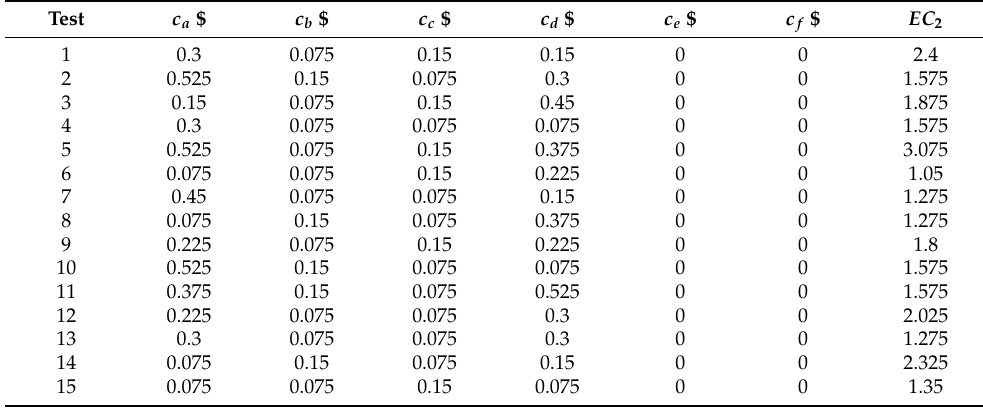
Table A6. Energy costs for fermentation-based extraction method ( i =